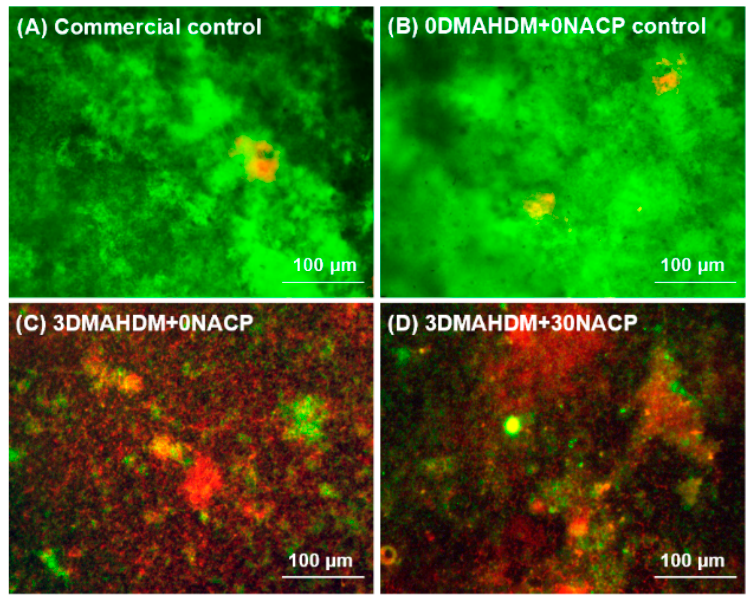
Figure 2. Representative images of live/dead stained biofilms grown for 48 h on composites. ( A ) Commercial control. ( B ) 0DMAHDM + 0NACP control. ( C ) 3DMAHDM + 0NACP. ( D ) 3DMAHDM + 30NACP. Live bacteria were stained green and dead bacteria were stained red. Commercial control and 0DMAHDM + 0NACP control composites had primarily live bacteria. 3DMAHDM + 0NACP and